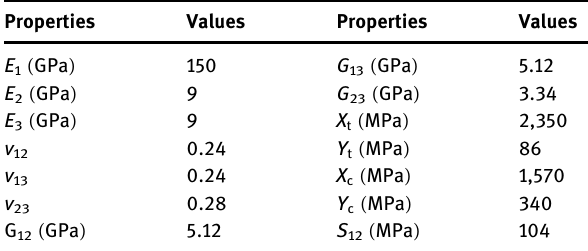
Table 2: Unidirectional composite properties ( T700/8002